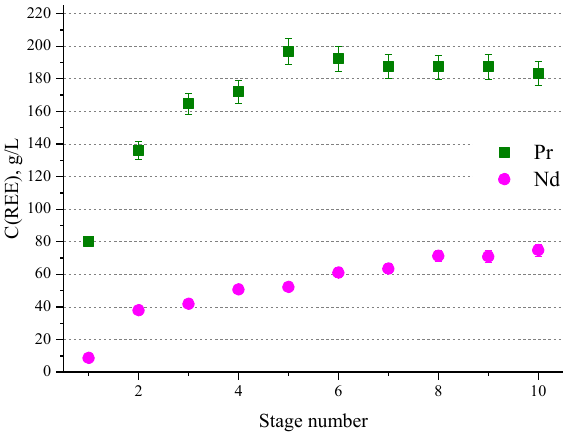
Figure 5. Concentration profiles for the aqueous phases in a steady state. O/A volume ratio = 1:1. Organic phase — 100% TBP.